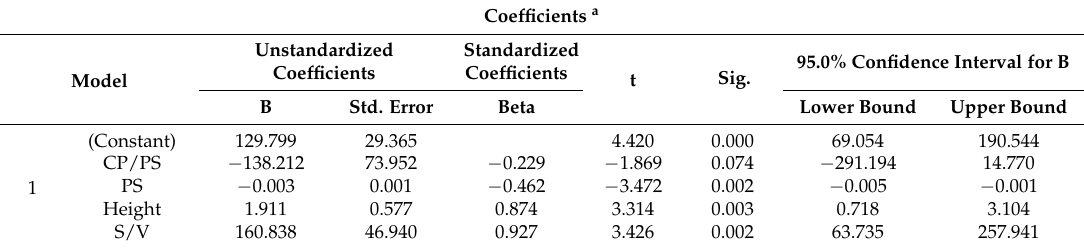
Table 15. Coefficients of regression model for Thessaloniki urban block load demand.